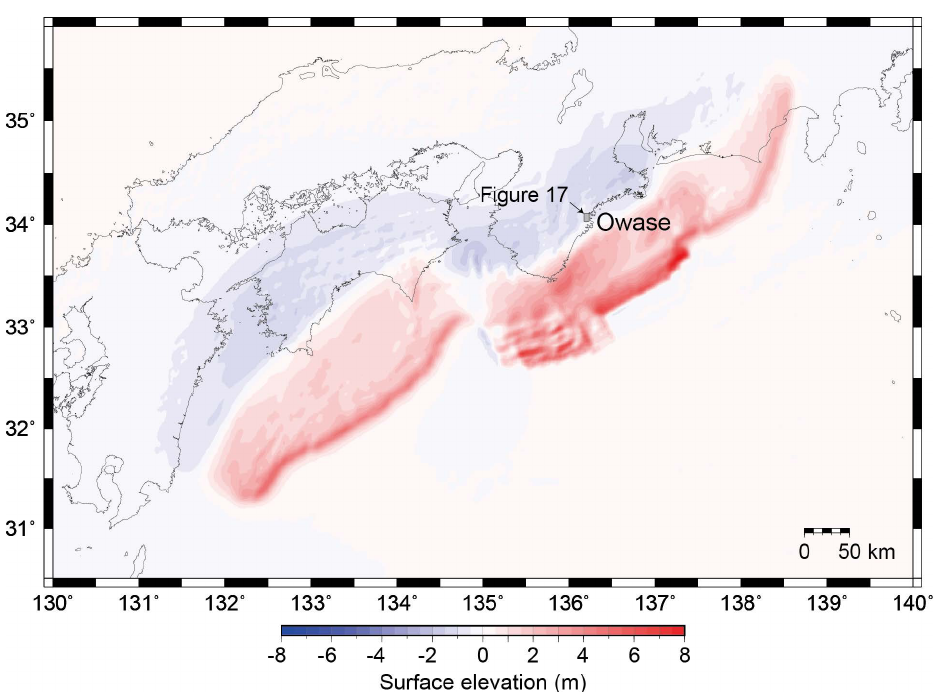
Figure 15. Example of a Cabinet Office tsunami source model (Case 7) showing surface elevation caused fault slip. The triangular symbol indicates the approximate center position of a typical Japanese local government along the Nankai Trough.